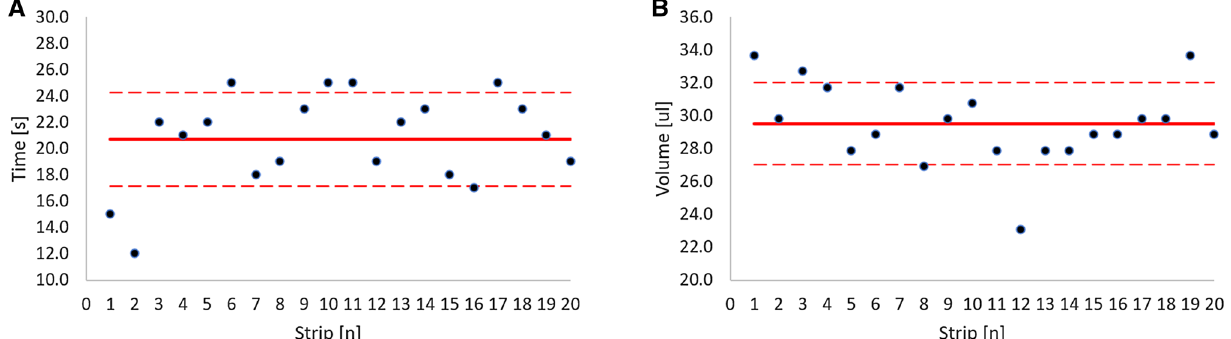
Figure 2. Variation in the fill time and volume of blood absorbed onto the volumetric sampling device. ( A ) complete filling time for 20 strips. ( B ) amount of blood absorbed by 20 strips. Solid red line: represents the average. Dotted red lines: represent the standard